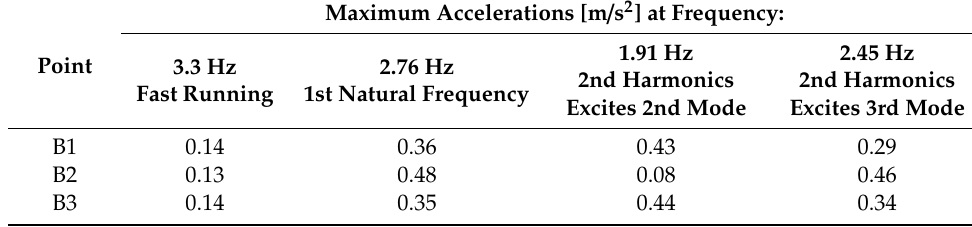
Table 14. Maximum vertical accelerations generated by a single pedestrian running obtained at the representative points of the beam footbridge with the GFRP slab for the selected frequencies.